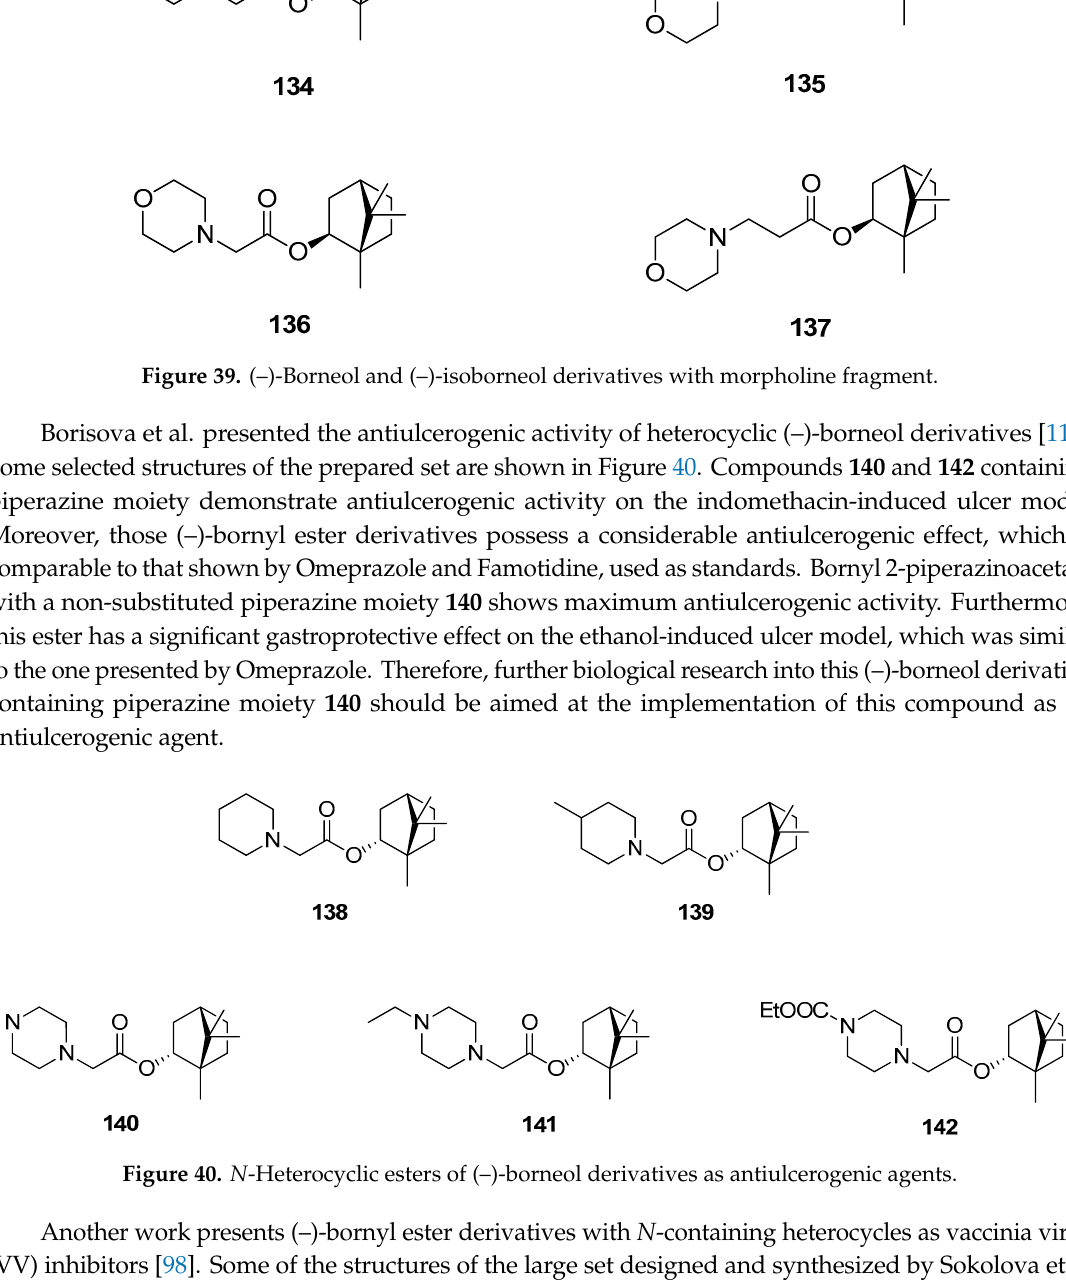
Figure 38. (–)-Borneol ester derivatives with different N - and S -nucleophiles.